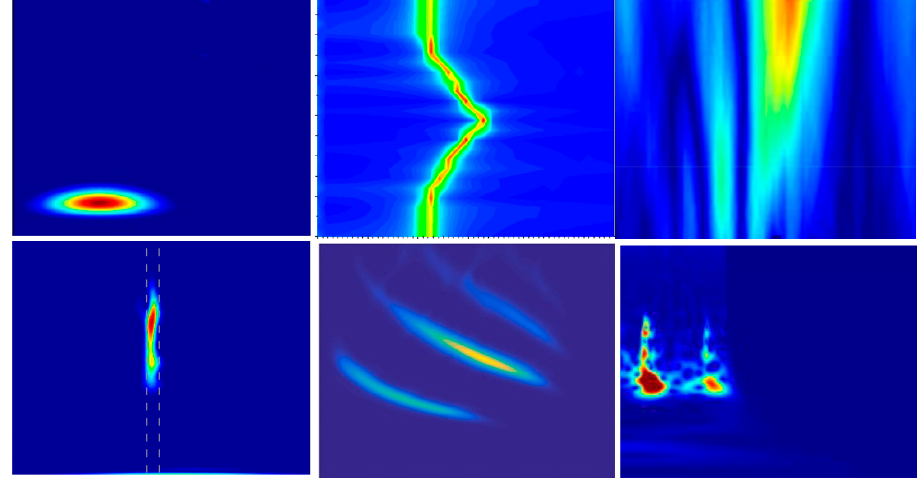
Figure 17. NDT Scalogram.